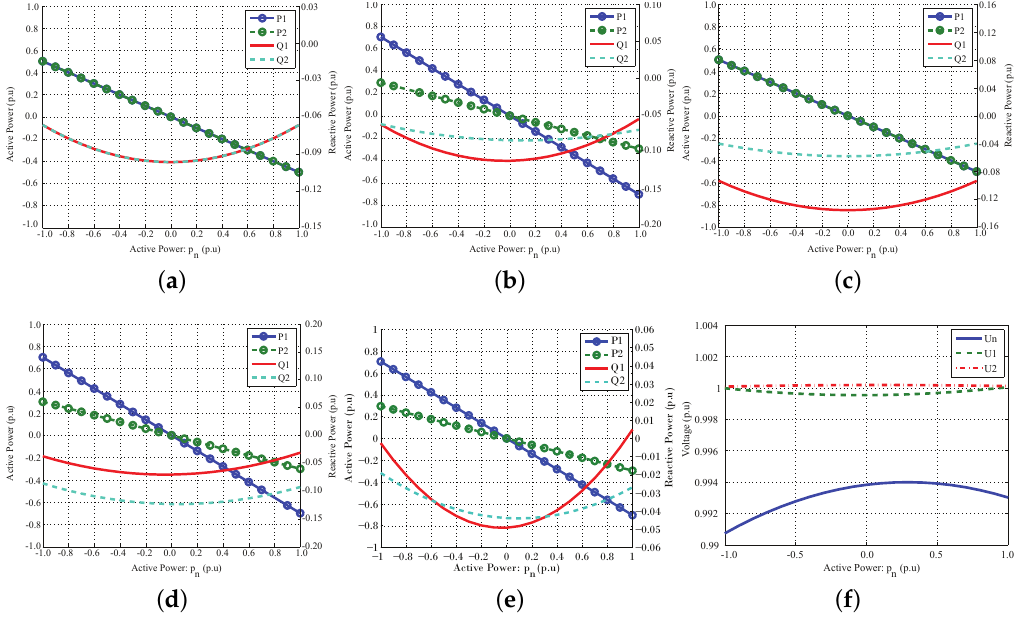
Figure 8. Steady-state response of the network power and voltage level with respect to the p n at several power contribution factors: ( a ) p n = 0.8 p.u, q n = 0.0 p.u, α = β = 0.5; ( b ) p n = 0.8 p.u, q n = 0.0 p.u, α = 0.3, β = 0.5; ( c ) p n = 0.8 p.u, q n = 0.0 p.u, α = 0.5, β = 0.3; ( d ) p n = 0.8 p.u, q n = 0.0 p.u, α = 0.3, β = 0.7; ( e ) p n = 0.8 p.u, q n = − 0.1 p.u, α = 0.3, β = 0.7; ( f ) p n = 0.8 p.u,